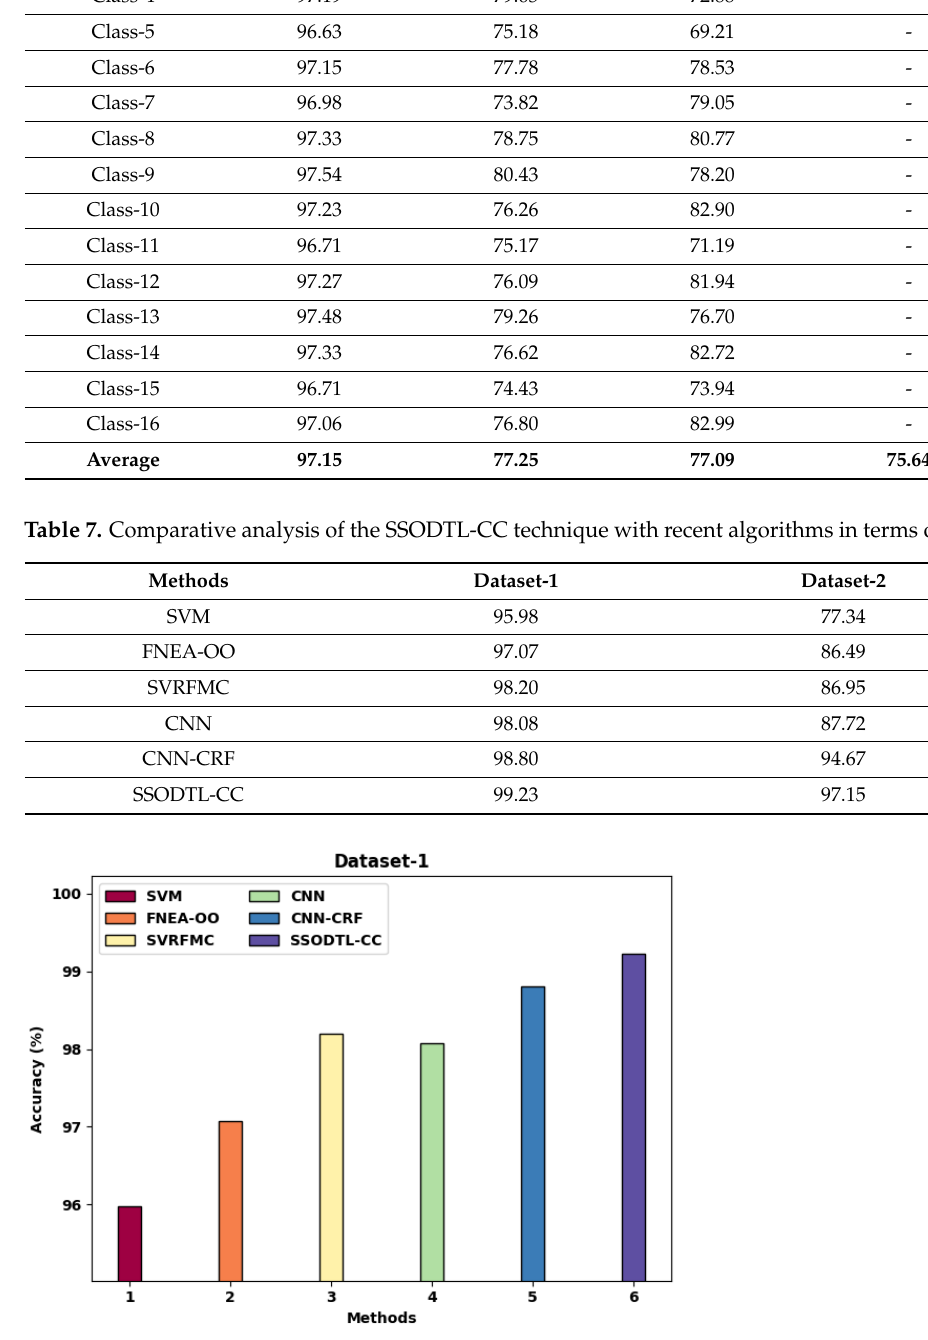
Figure 6. Comparative analysis of the SSODTL-CC technique under dataset-1. Figure 7 examines a comparative classification outcome of the SSODTL-CC model with existing approaches on dataset-2. The outcomes indicated that the SVM model